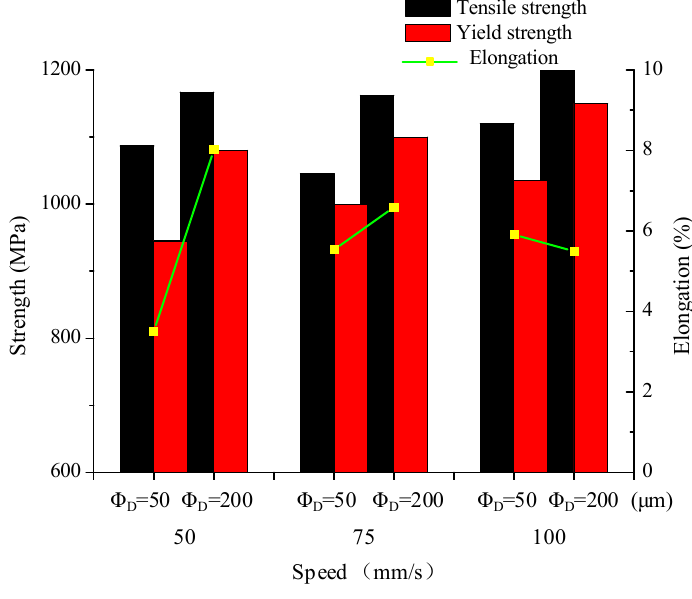
Figure 12. Tensile properties of samples produced by SLM using different laser beam diameters.